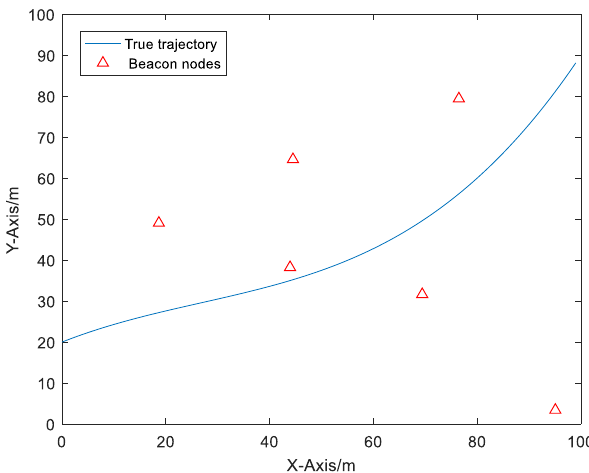
Figure 3. The simulation scene of a Monte Carlo